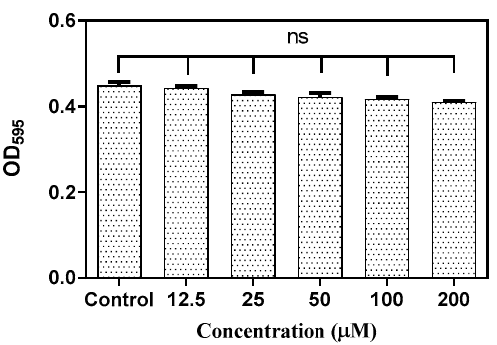
Figure 2. Effect of Baicalein on S. gordonii growth at varying concentrations. Student t test was used for the significance analysis. p < 0.05 was considered significant. ns denotes non-significance.